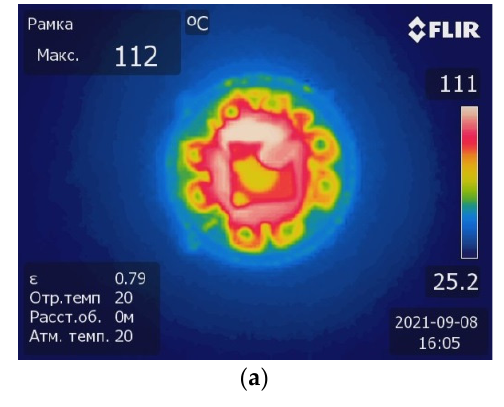
Figure 5. The results of the thermal imaging of MIS sensors with different heater configurations at an operating temperature of 100 °C: ( a ) standard assembly in a glass–metal package; ( b ) new assembly in a planar SMD package.